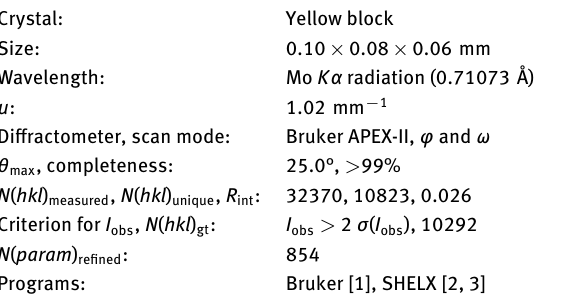
Table 1: Data collection and